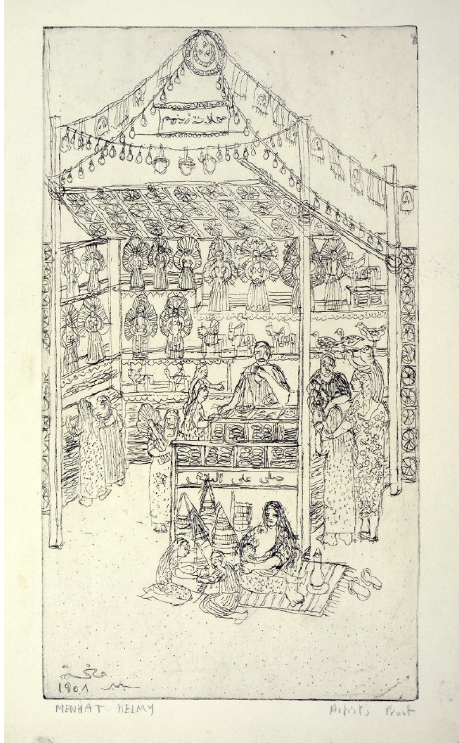
Figure 14. Menhat Helmy, Zeinhoum’s Market (1958). Etching, 15.5 × 21 cm. Courtesy of estate of Menhat Helmy.